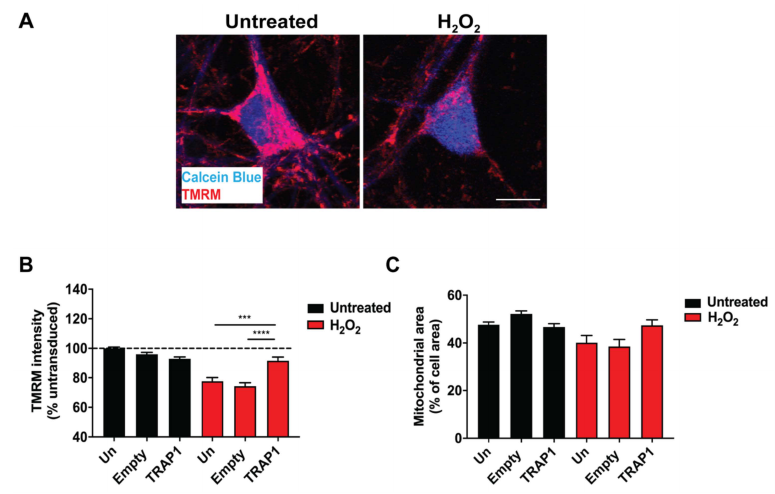
Figure 1. TRAP1 overexpression in motor neurons rescues H 2 O 2 –induced loss of mitochondrial membrane potential. ( A ) Representative images of TMRM and calcein blue fluorescence in primary motor neurons treated with 100 µ m H 2 O 2 for 6 h. ( B ) Quantification of TMRM intensity measurements from lentivirally treated motor neuron cultures exposed to 100 µ m H 2 O 2 for 6 h, Un: Untreated. ( C ) Mitochondrial area measurements from lentivirally treated motor neuron cultures exposed to